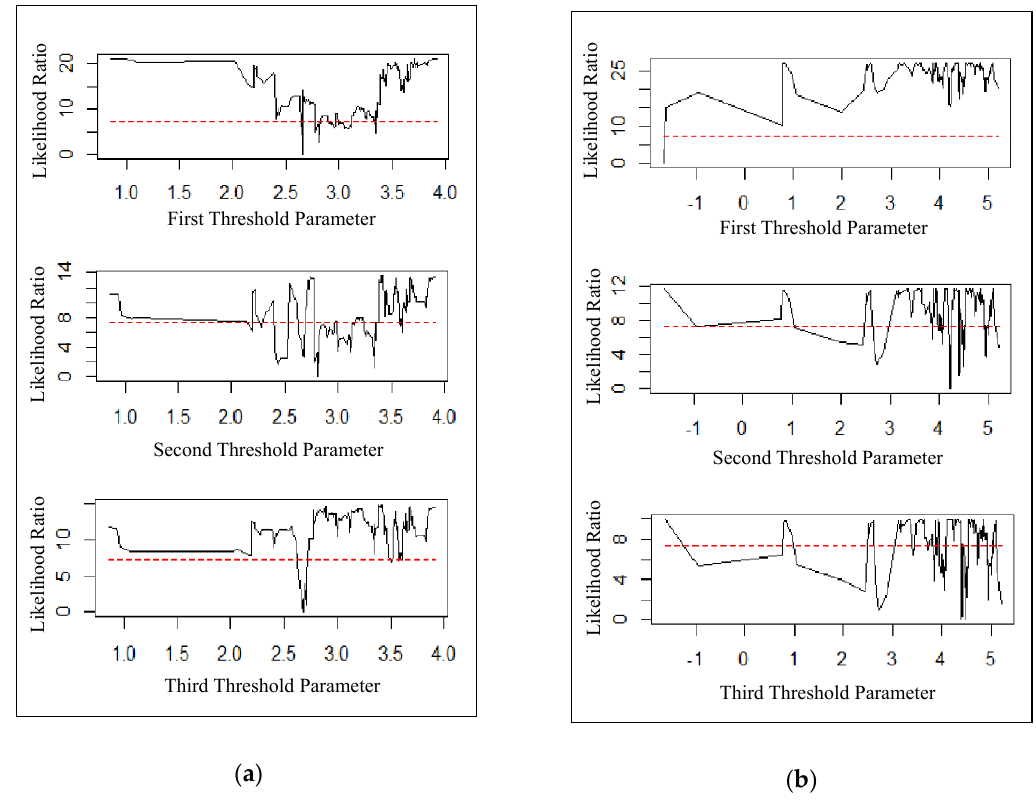
Figure 2. Confidence interval construction in ( a ) PM 2.5 thresholds and ( b ) SO 2 thresholds. Note: The dashed line denotes the critical value (7.35) at the 95% confidence level.